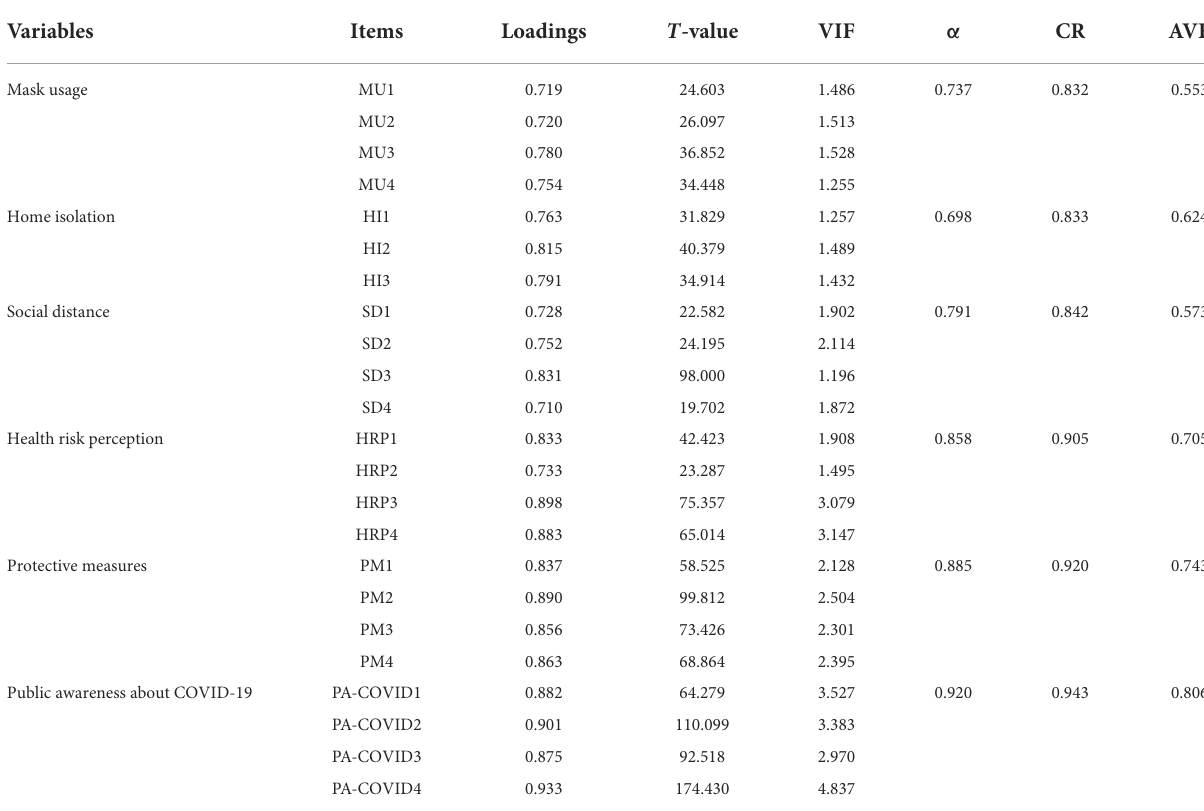
TABLE 1 Reliability and validity